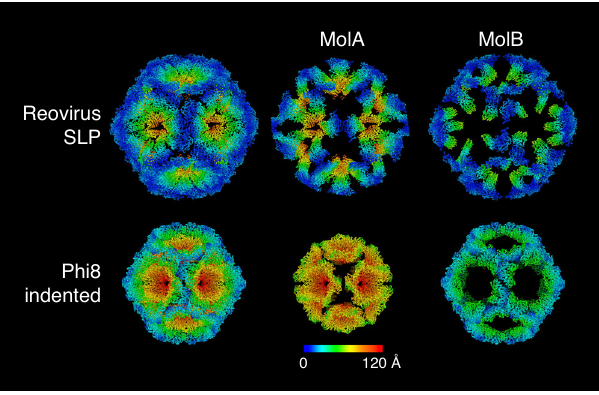
Fig. 4 Similarity between the SLP and the indented form of Phi8 procapsid. The structures are coloured according to the distance of equivalent C α ’ s between the indented and expanded forms of each virus. For clarity, only the indented state of each virus is shown. For both viruses molecule A moves more than molecule B, although it should be noted that there is greater movement between the two particle forms in